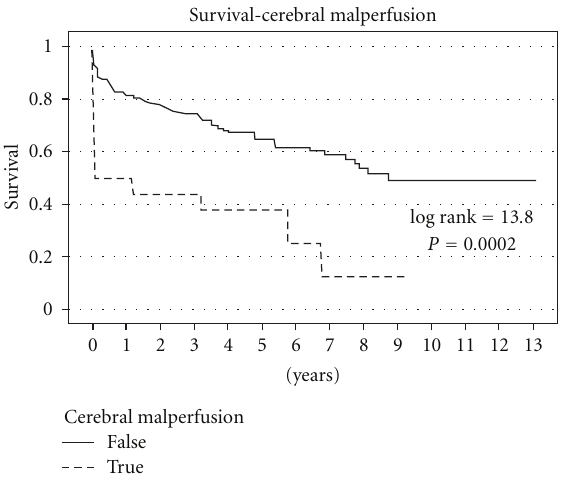
Figure 3: Kaplan Meier survival curves of actuarial survival of patients with cerebral malperfusion syndrome undergoing acute type A aortic dissection repair. Reproduced with permission from Geirsson et al.